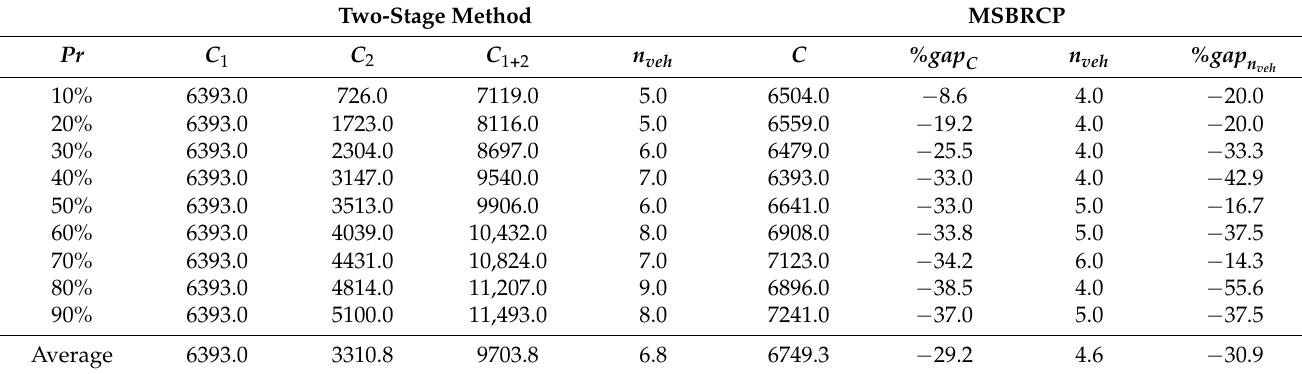
Table 9. Comparison results of the two-stage method and MSBRCP on instance ( | V | = 30, | VD | = 2). Two-Stage